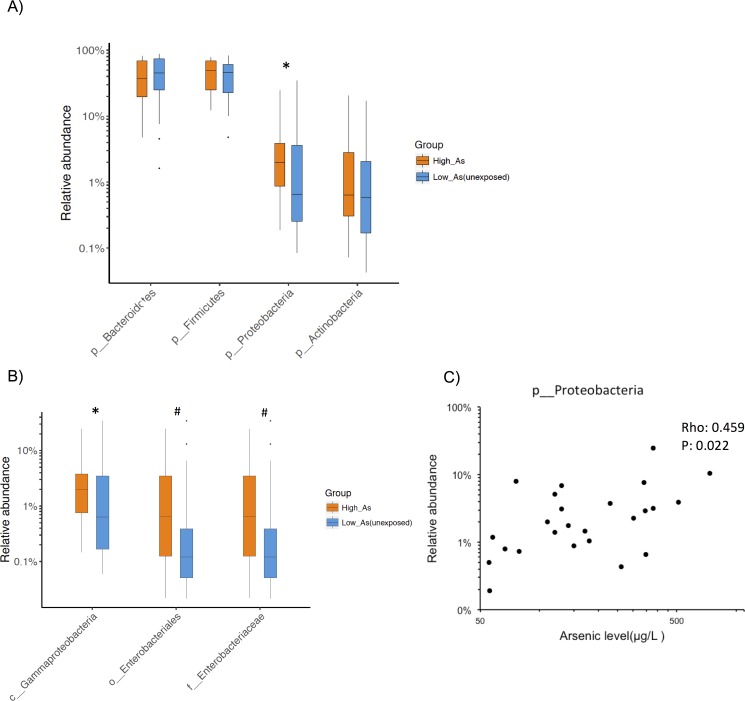
Microbial taxonomic composition in high arsenic exposure group and low arsenic exposure group based on 16S rRNA V4 gene region sequencing.(A) Relative abundance of phyla for high arsenic exposure samples (n = 25, orange color) and low exposure samples (n = 25, blue color). The boxplot represent interquartile range with the black bar indicating the median relative abundance and error bars represent minimum and maximum values. Outliers are represented by solid circles. *P<0.02, Mann–Whitney U test. (B) Relative abundance of three lower taxonomic ranks of phylum Proteobacteria for high arsenic exposure and unexposed samples. * P<0.03, # P<0.1(C) Correlation between relative abundance of phylum Proteobacteria and water arsenic level in high arsenic exposure group. p-value is calculated for two-tailedSpearman correlation coefficient.